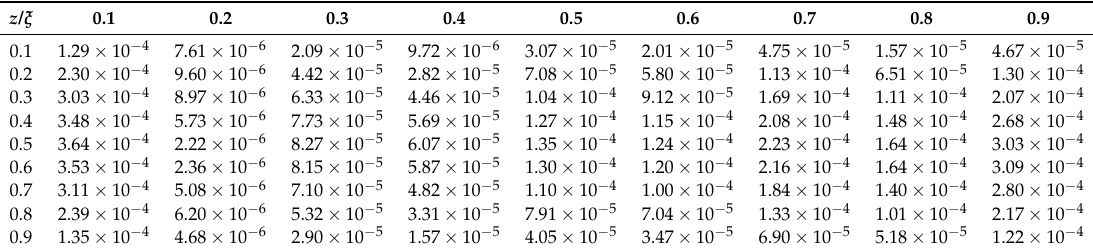
Table 4. Absolute error values of Example 1 for Burgers’ equation with α =